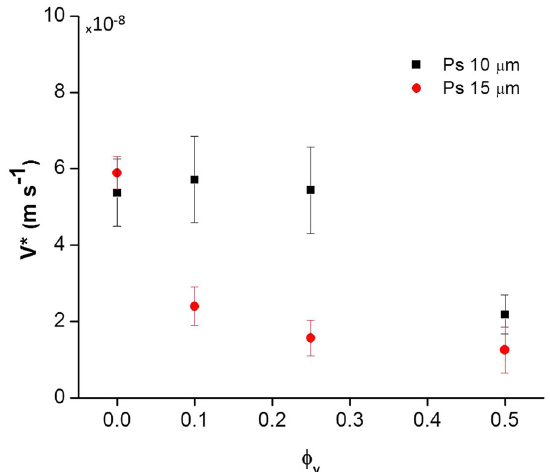
Fig. 9 Spreading velocity of hybrid aggregates as a function of particle volume fraction. Spreading velocity V* of Ps-10 and Ps-15 microparticles as a function of microparticle volume fraction Φ v . Error bars represent the standard deviation of n = 10 aggregates. Table 3 Repartition of microparticles and cells in aggregates at different stages.